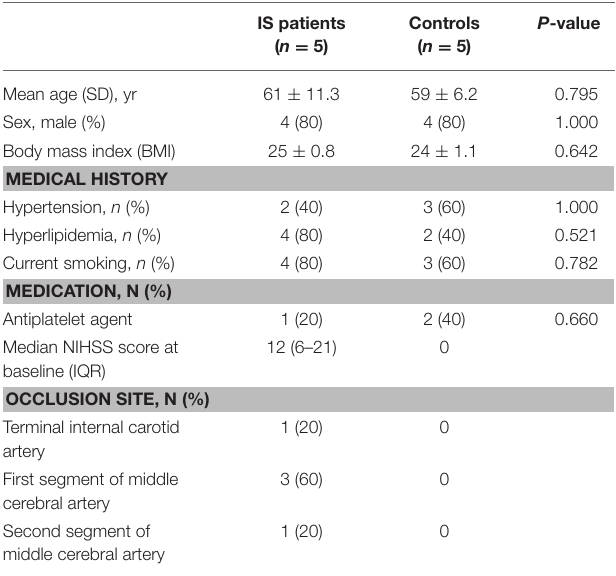
TABLE 1 | Clinical characteristics of ischemic stroke patients and vascular risk factor-matched controls.